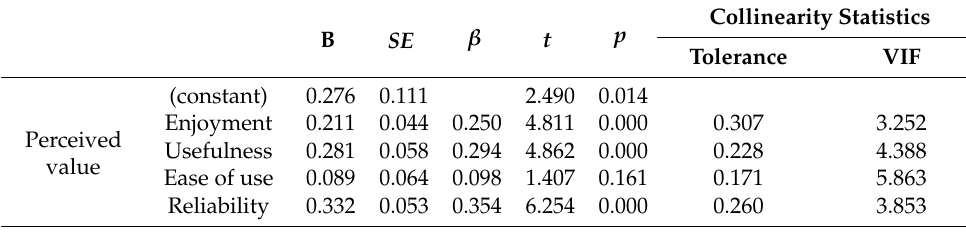
Table 5. Effect of TBSS characteristics on perceived